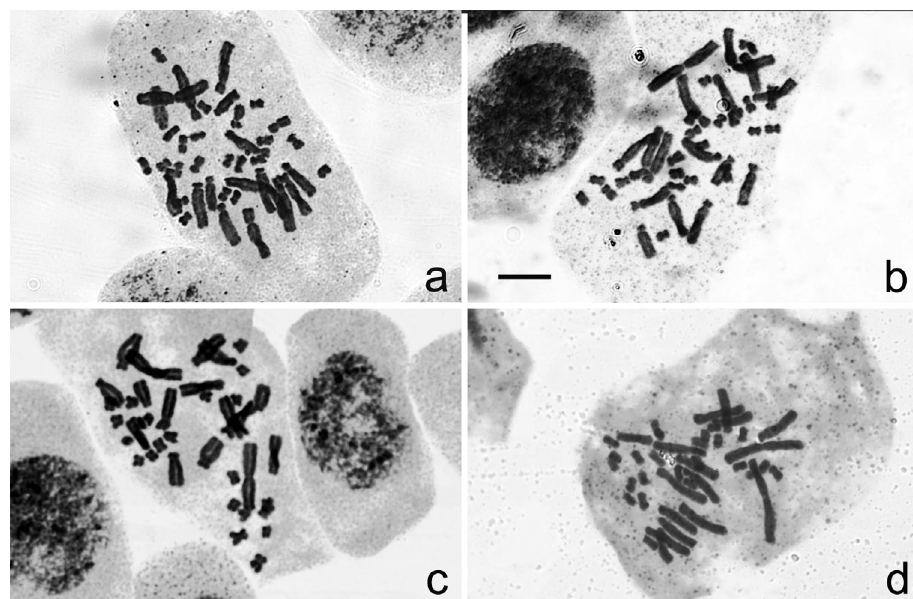
Figure 2. Somatic Chromosome at mitotic metaphase in Aspidistra subrotata of 2n = 38. a Mt. Poman population b, c Mt. Daqing population d Mt. Bavi population. Bar = 10